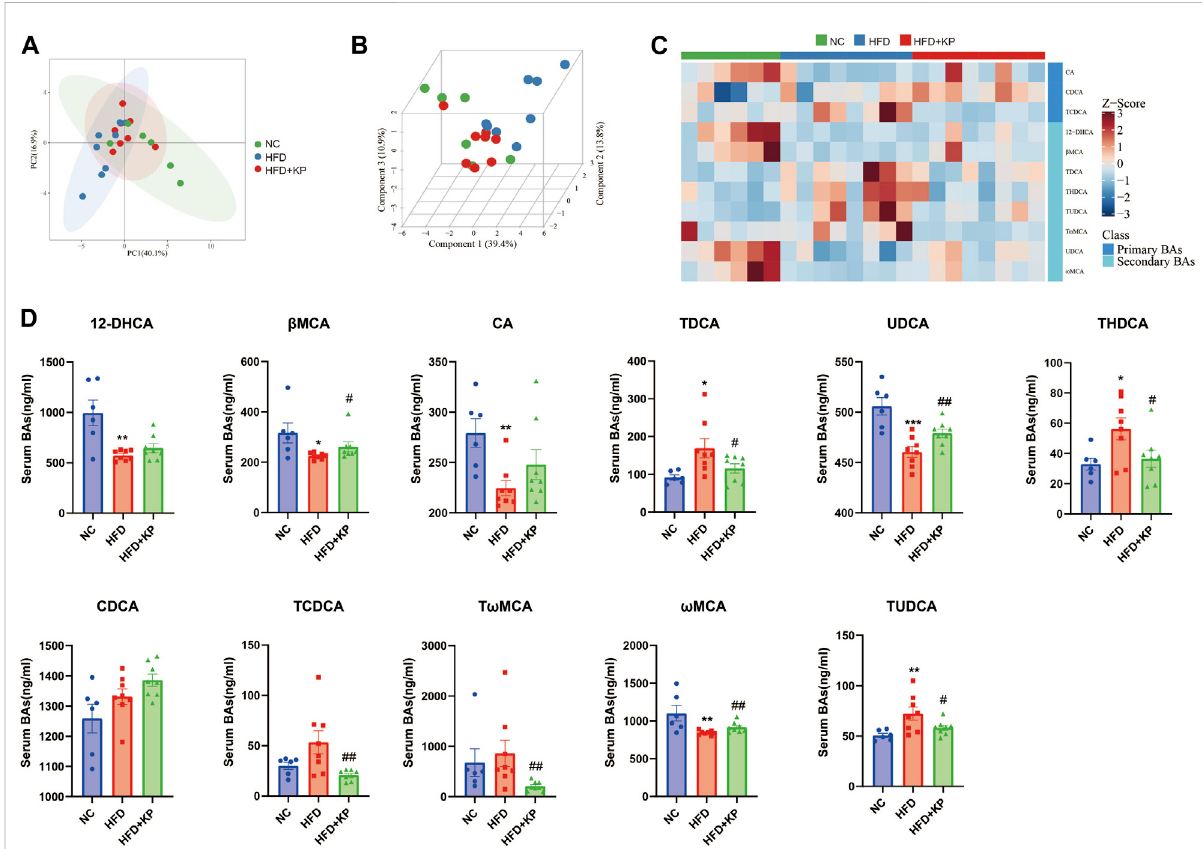
FIGURE 1 Comparison of the serum BA level and composition among three groups. (A) PCA score plots show separation among three groups based on 19 serum bile acids. (B) PLS-DA score plots show clear separation among three groups based on 19 serum bile acids. (C) Heatmap of 11 serum bile acidbiomarkersamongthreegroups. (D) Differentialserumbileacidssigni fi cantlydifferedamongthreegroups.Allvalueswereexpressedasmean± SEM. * p < 0.05, ** p < 0.01, and *** p < 0.001, when NASH models (HFD group) were compared to control groups (NC group); # p < 0.05 and ## p < 0.01, when NASH models (HFD group) were compared to NASH models treated with kaempferol (the HFD + KP